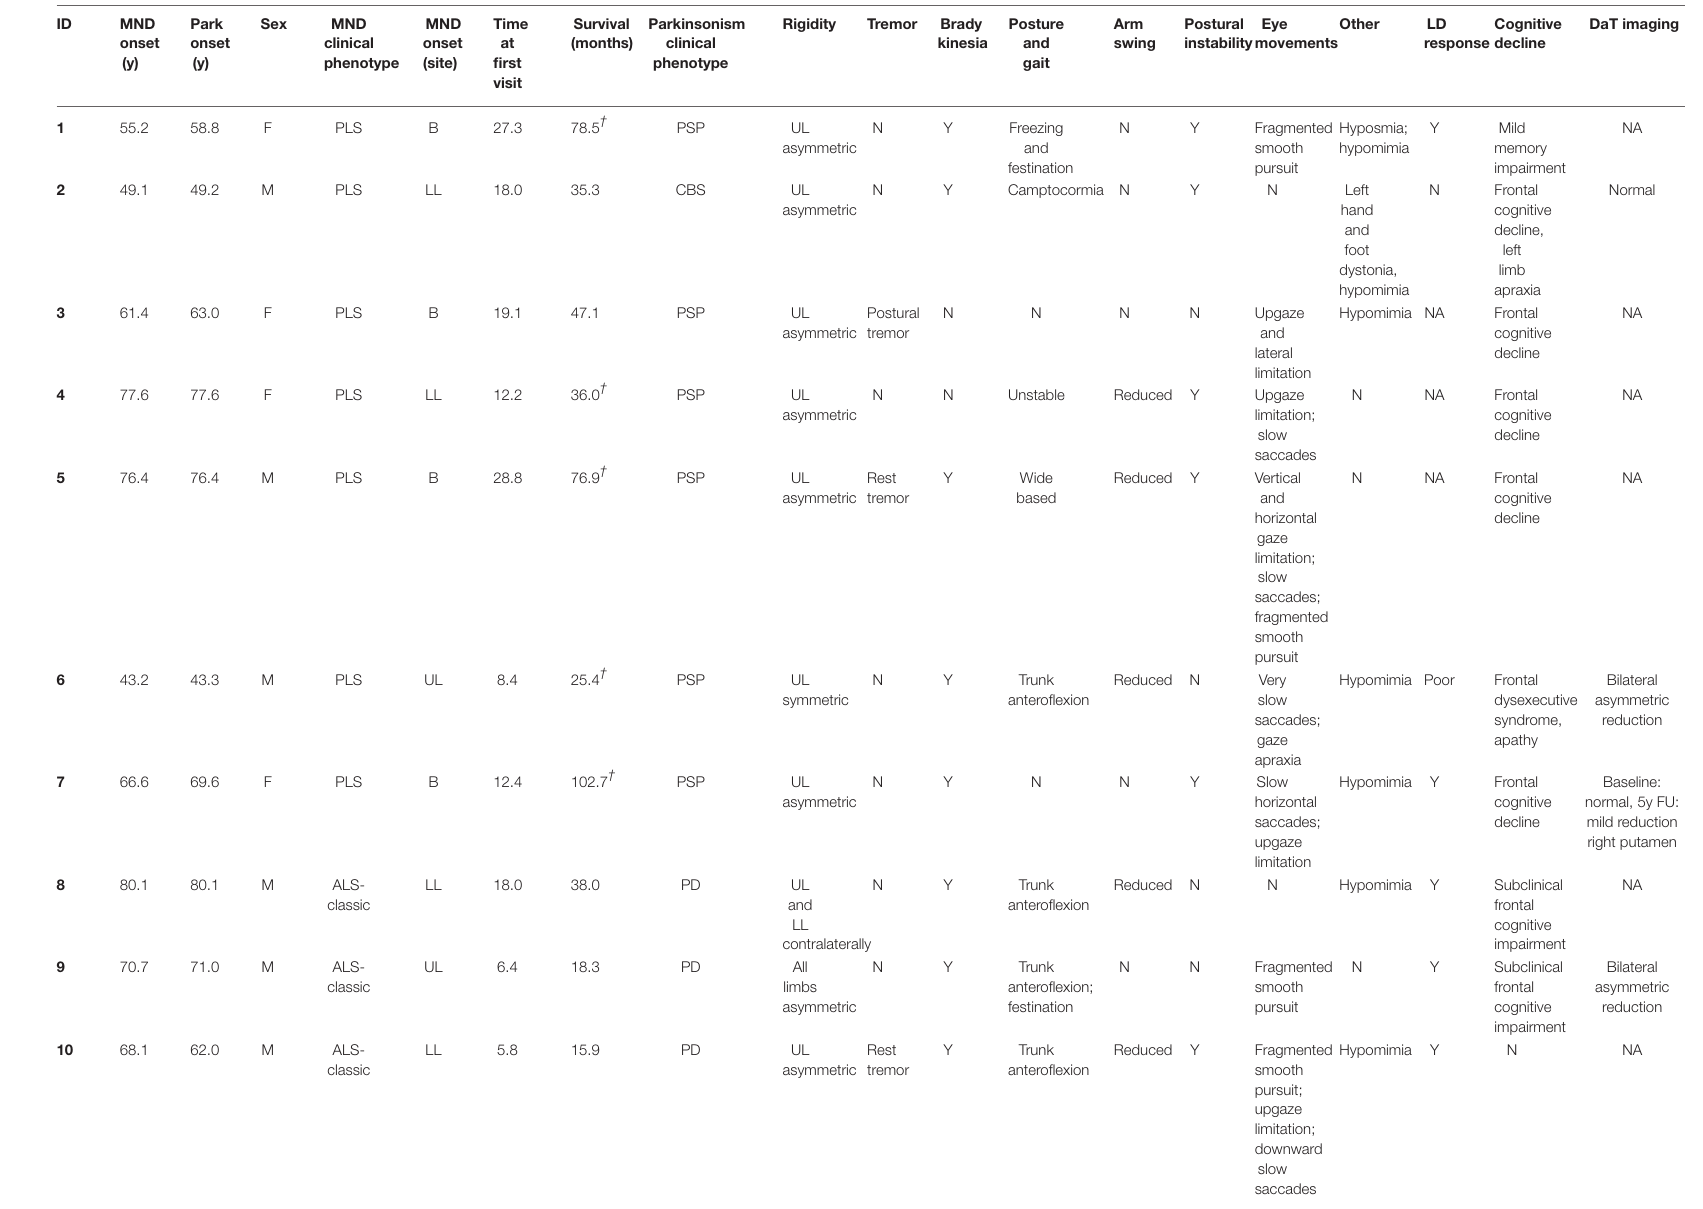
TABLE 1 | Detailed clinical characteristic of the 18 patients with a MND-parkinsonism